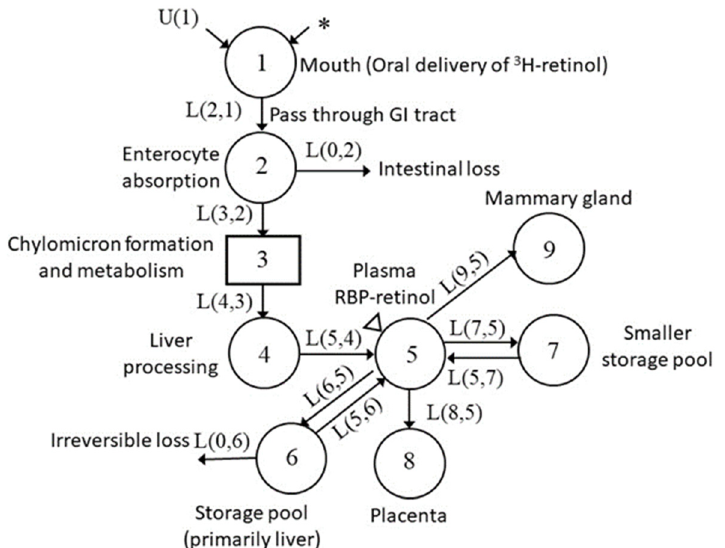
circle represents a different compartment, the rectangle represents a delay component, arrows indicate the transfer of VA from one compartment to another compartment. The asterisk indicates the site of entry of the 3 H-labeled retinol dose into the system, U(1) indicates the dietary intake of VA, and the triangle indicates the site of sample collection (plasma).